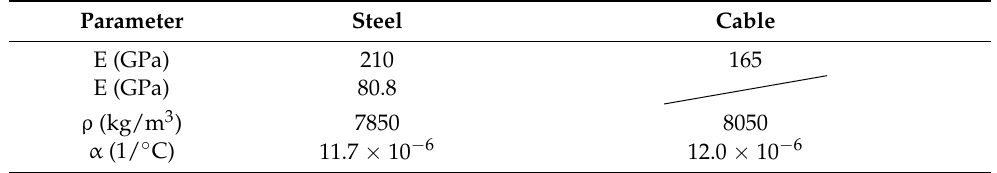
Table 3. Statistical table of material characteristics.